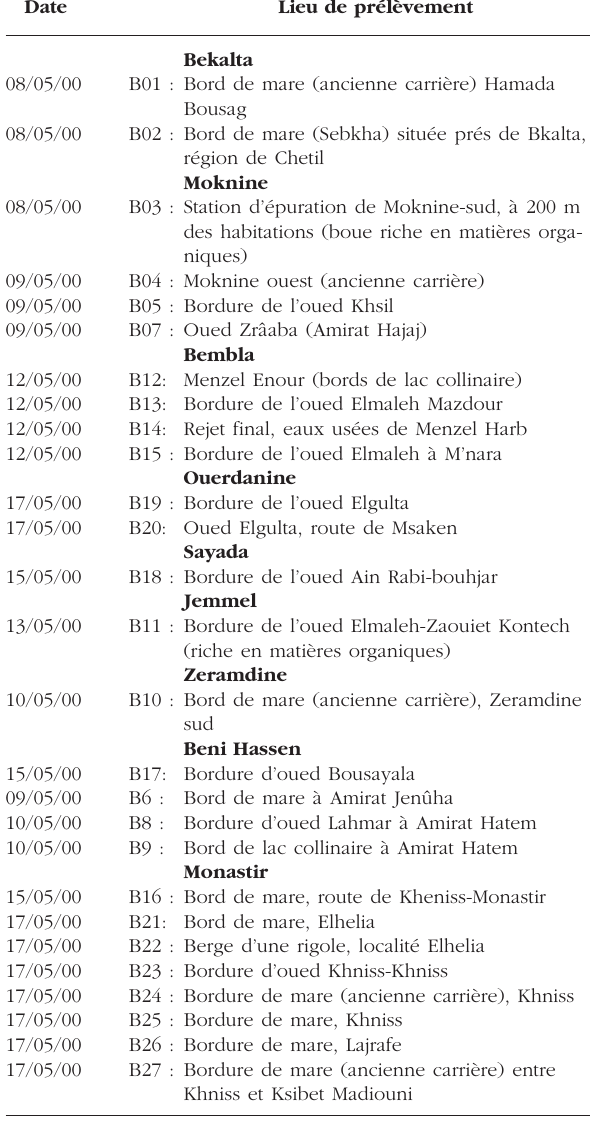
Tableau I. – Biotopes larvaires.